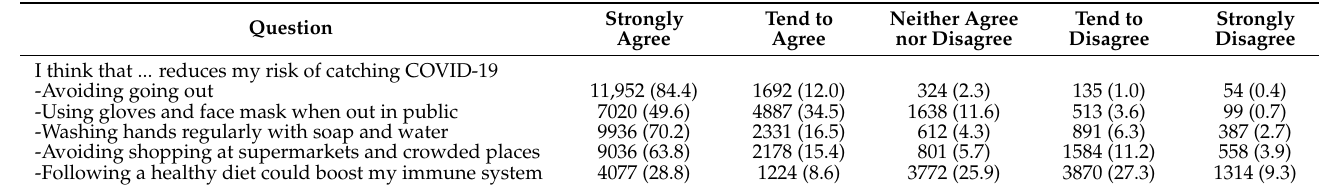
Table 2. Attitude of participants towards COVID-19